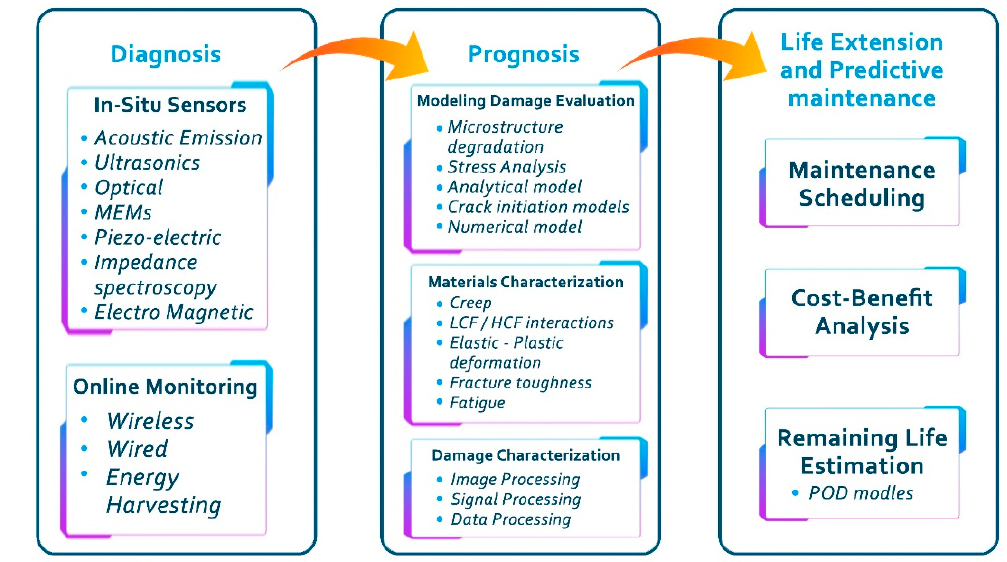
Figure 2. Progression and advancement of SHM in